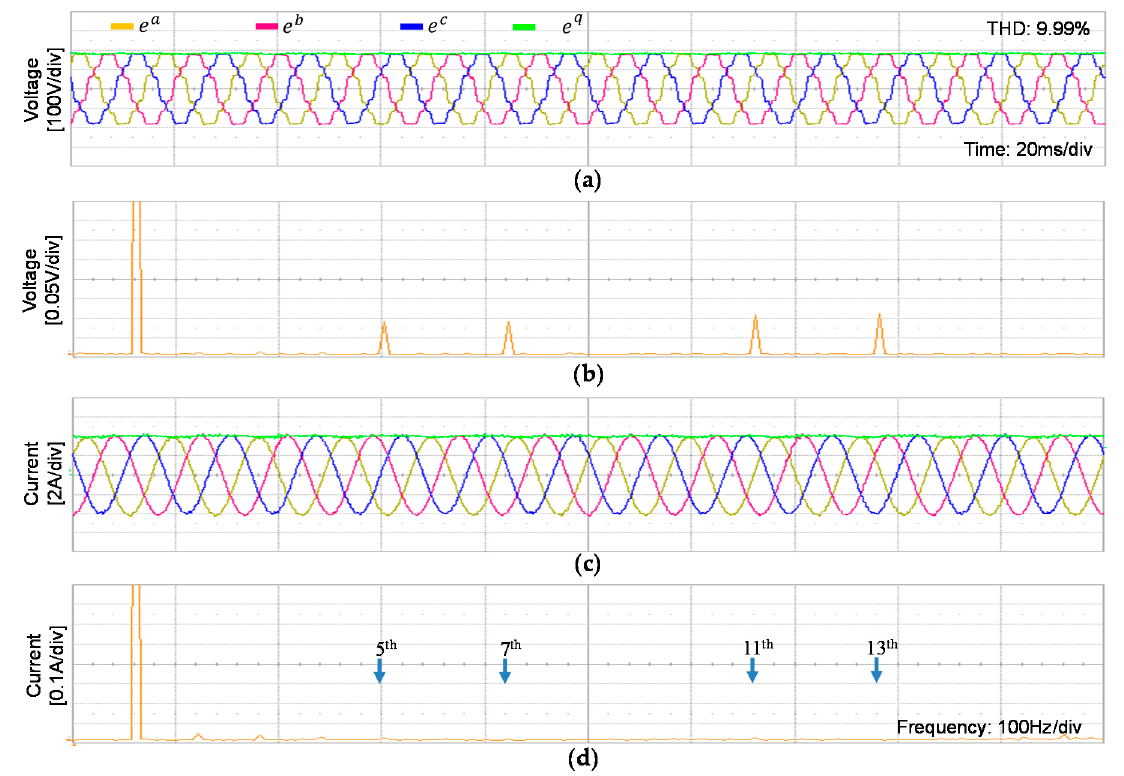
Figure 17. Experimental results of the proposed controller under three-phase distorted grid voltages. ( a ) Three-phase grid voltages; ( b ) FFT result of phase- a voltage; ( c ) three-phase grid currents; and ( d ) FFT result of phase- a current.